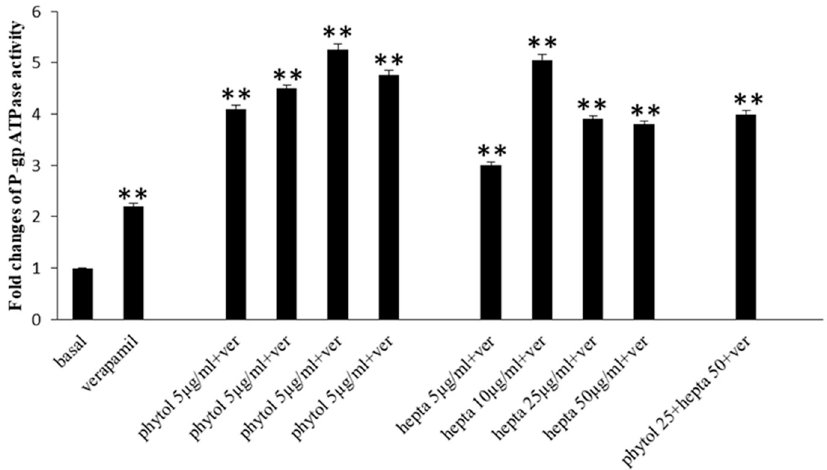
Figure 9. Effects of phytol and heptacosane (hepta; 5–50 µg/mL) on 0.5 mM verapamil(ver)- stimulated P-gp ATPase activity. The data are expressed as fold changes of P-gp ATPase activity compared to basal one ( ∆ RLU TC / ∆ RLU basal ) and are presented as mean ± S.E. of three experiments, each in duplicate. Differences when treatments are compared to the basal activity, ** p < 0.01 (one-way ANOVA followed by Tukey’s test).